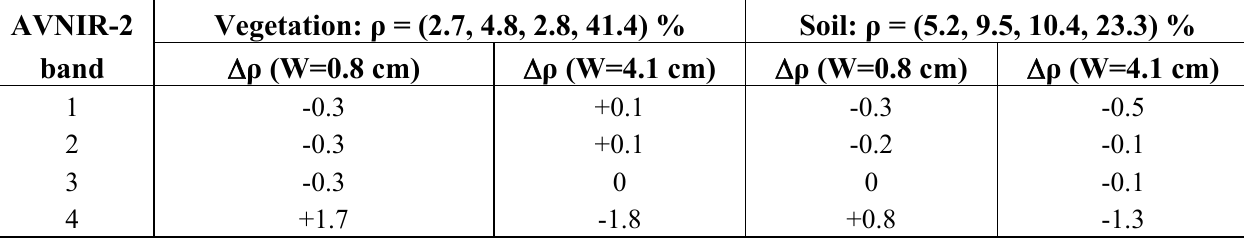
Table 1. Surface reflectance retrieval error  ρ (percent reflectance) for W=0.8 and 4.1 cm. The true water vapour column is W=2.0